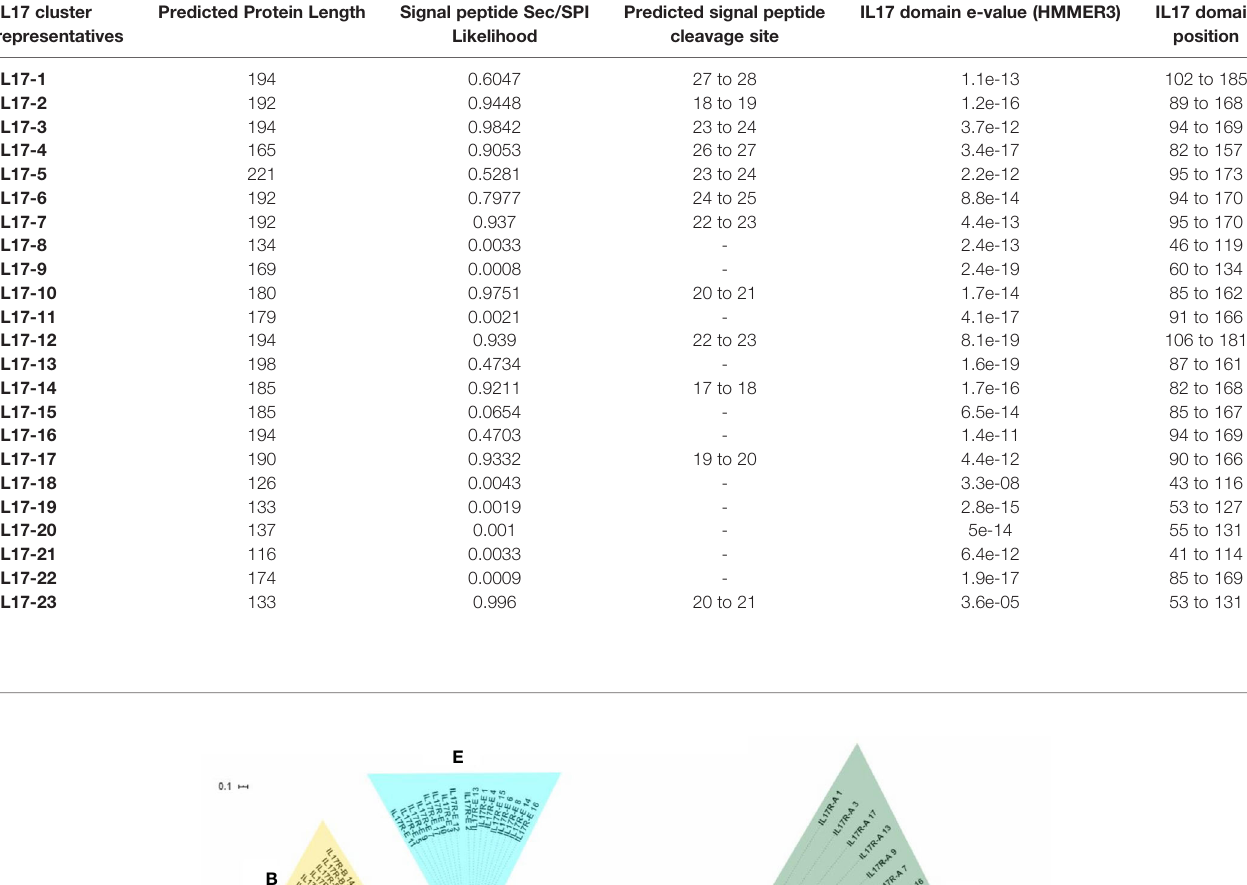
TABLE 2 | Sequence and domain information of the 23 isoforms of mussel